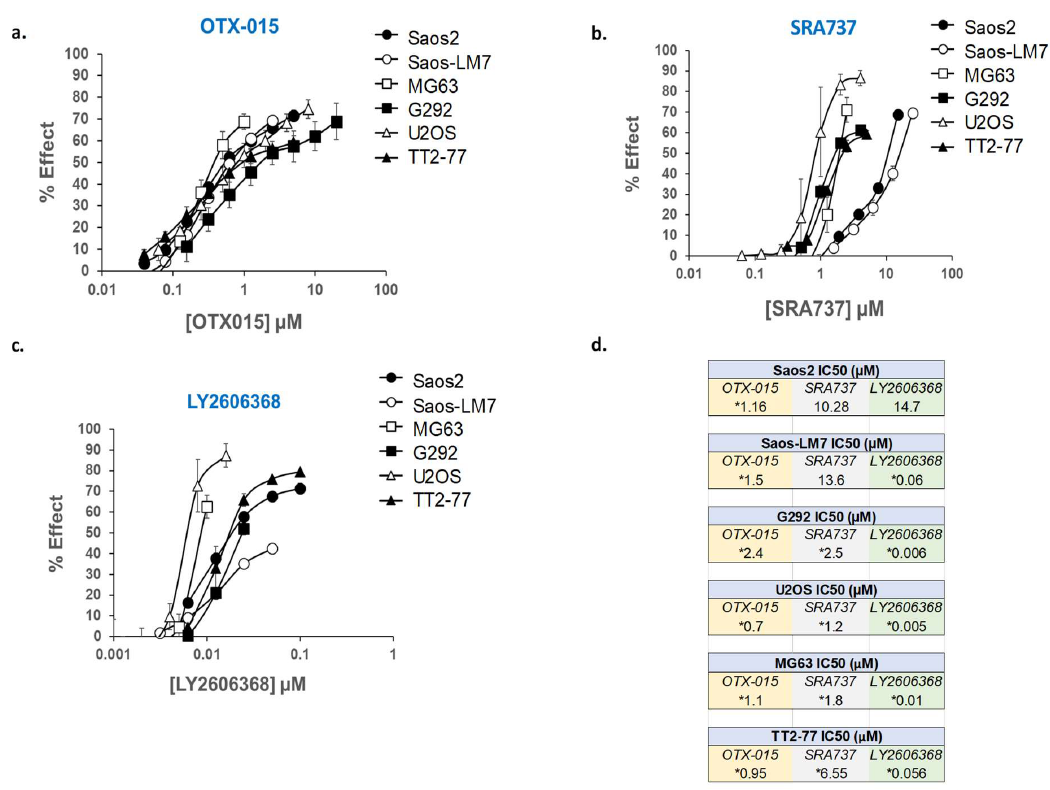
Figure 4. Dose-response curves for OTX-015, SRA737, and LY2606368, evaluated as single agents in a panel of established pediatric OS cell lines and TT2-77 xenoline. Dose-related inhibition of cell growth in the presence of ( a ) OTX-015, ( b ) SRA737, and ( c ) LY2606368 in pediatric OS cell lines. ( d ) Concentration required as single agents to inhibit 50% cell growth (IC50) in pediatric OS cell lines. Cell proliferation was determined by methylene blue staining after 5 days of drug exposure. Each point represents the mean of three experiments, each conducted in triplicate. Vertical lines represent ± one standard deviation and are absent when less than the size of the point. µM, micromolar. * Within the range of clinically achievable concentrations in human plasma.